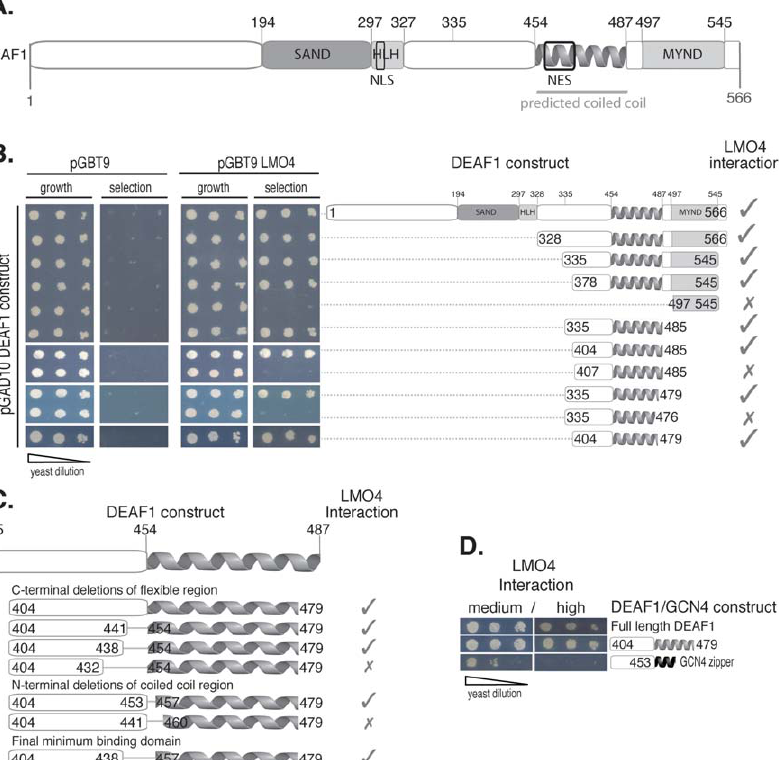
Figure 1. Establishing the LMO4-binding region of DEAF1. A. Schematic domain structure of the mouse DEAF1 protein containing a DNA- binding SAND (Sp100, AIRE-1, NucP41/75, DEAF11), a Helix-Loop-Helix (HLH) domain, a predicted coiled coil region (depicted as a helix), a protein- binding MYND (myeloid translocation protein 8, Nervy, DEAF1) domain, a nuclear localization signal (NLS) and a nuclear export signal (NES). The previously identified LMO4-binding region (335–545) [4] is indicated (thin grey line). B. Yeast two-hybrid experiments where Saccharomyces cerevisiae (AH109) were co-transformed with full-length DEAF1 fused to a transcriptional activator domain (pGAD10) and LMO4 fused to a DNA binding domain (pGBT9). Co-transformants were serially diluted and spotted on growth ( 2 L/ 2 W; growth) and high stringency interaction plates ( 2 L/ 2 W/ 2 H/ 2 A; selection). Left-most panels show controls. Schematic on right shows corresponding domain truncations of DEAF1 constructs used in the assays. Growth of yeast or its absence on selection plates indicates an interaction (ticks) or an abrogation of the interaction (crosses) with LMO4 respectively. C. DEAF1 internal deletion mutants were tested for interaction with LMO4 by yeast two-hybrid assays; interactions are represented as above. D. Yeast two-hybrid data for DEAF1/LMO4 interactions to assay replacement of the DEAF1 coiled coil domain by the dimeric GCN4 leucine zipper. Selection was medium/high stringency ( 2 L/ 2 W/ 2 H + 3AT)/( 2 L/ 2 W/ 2 H/ 2 A). Yeast two-hybrid spot test results are shown. Three dilutions (A 600nm =0.2, diluted serially 2 6 1-in-10) are spotted left to right to show differences in growth under each selection